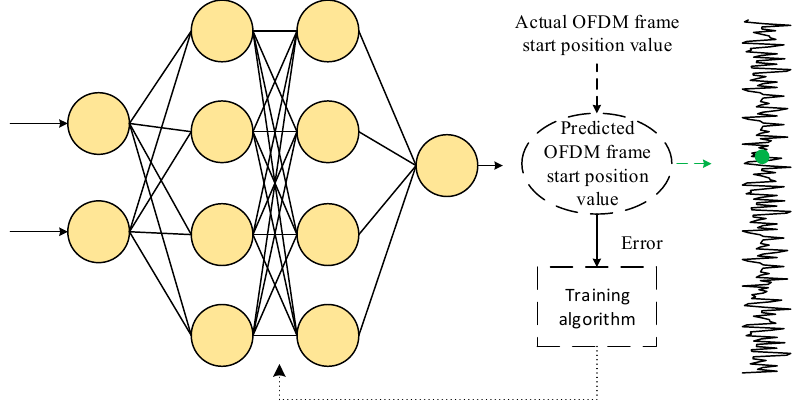
Figure 3. Deep learning for the starting point of OFDM